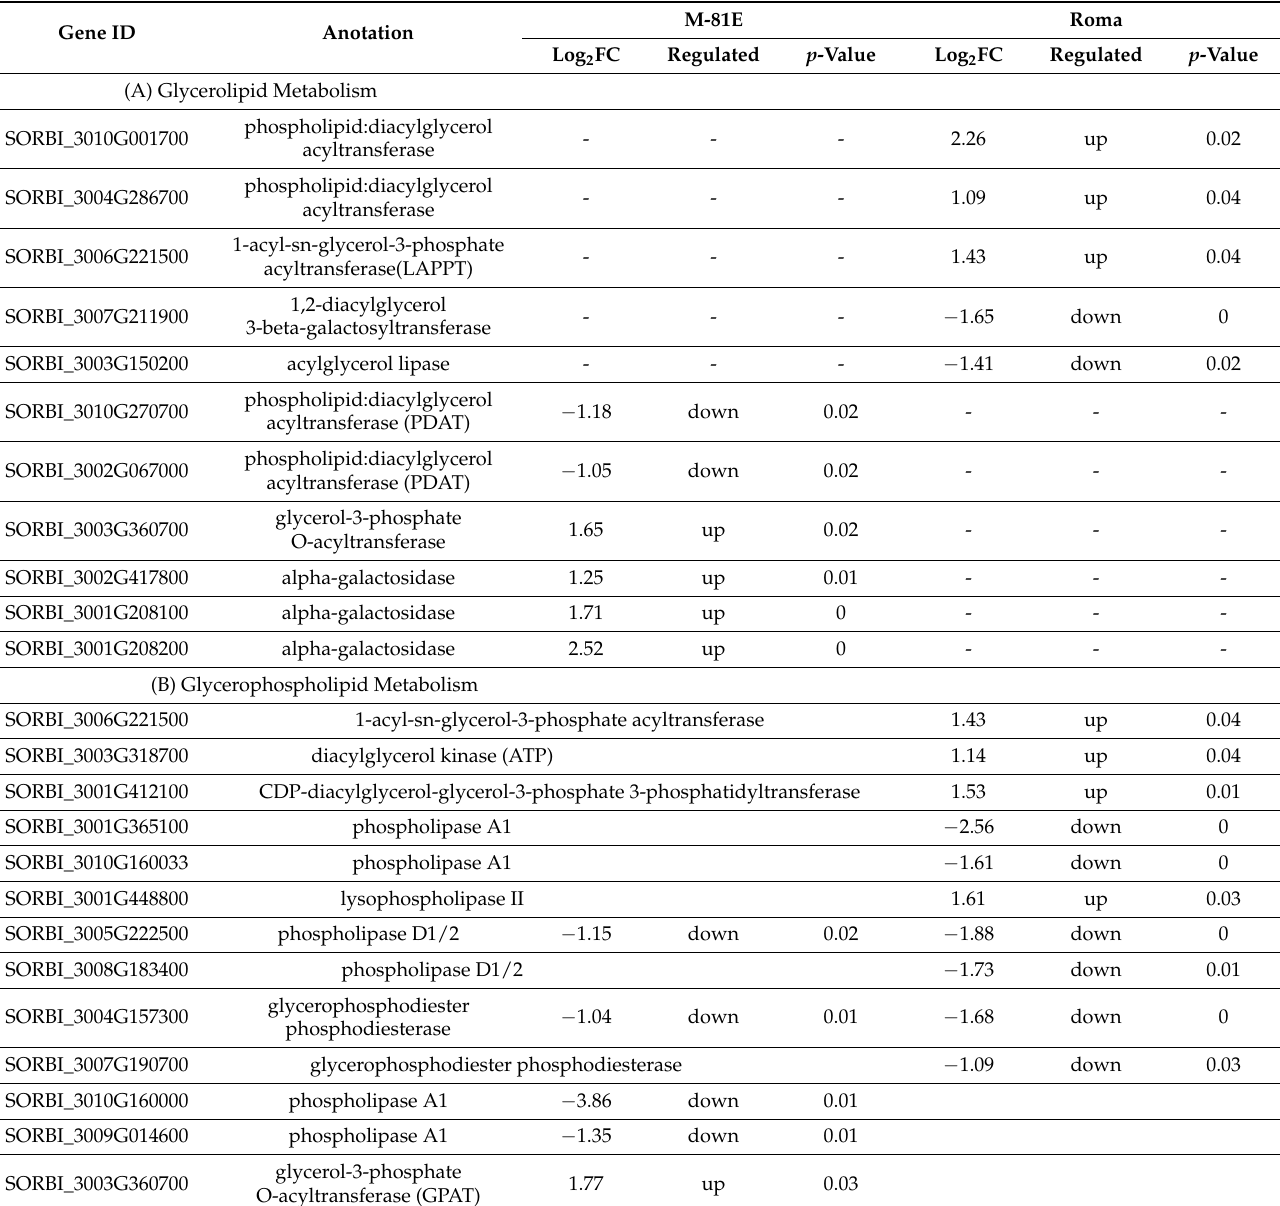
Table 1. DEGs mapped to KEGG pathways related to lipid